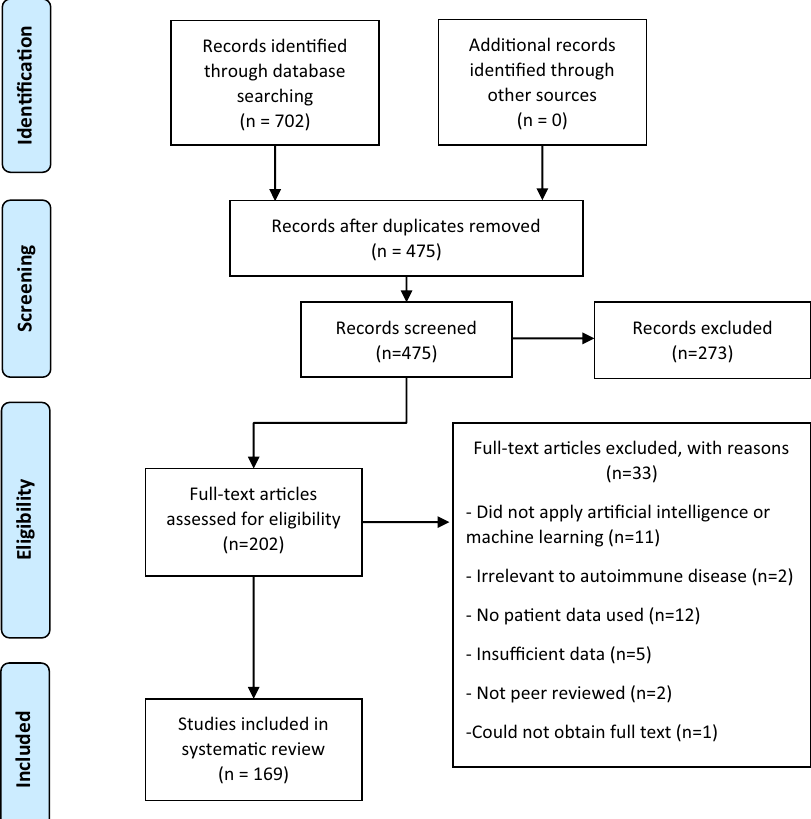
Fig. 3 Methodological fl owchart and number of papers reviewed at each stage. The inclusion and exclusion criteria are applied to the title and abstract at the screening step and to the full article at the eligibility step. During the screening step, it was unclear from some abstracts if the article ful fi lled the criteria, and therefore a full read is completed at the eligibility step to clarify the status of those records. Two reviewers completed screening independently, and where consensus could not be reached, a third reviewer assessed these articles and decided whether they were included or